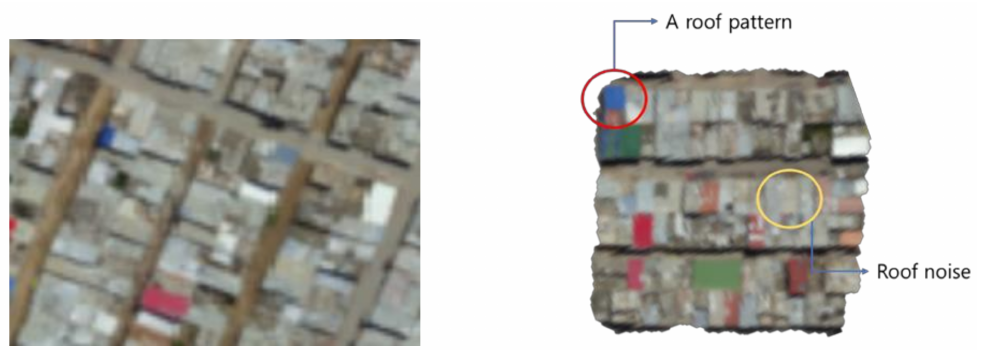
Figure 3. Roof area Image with noise and